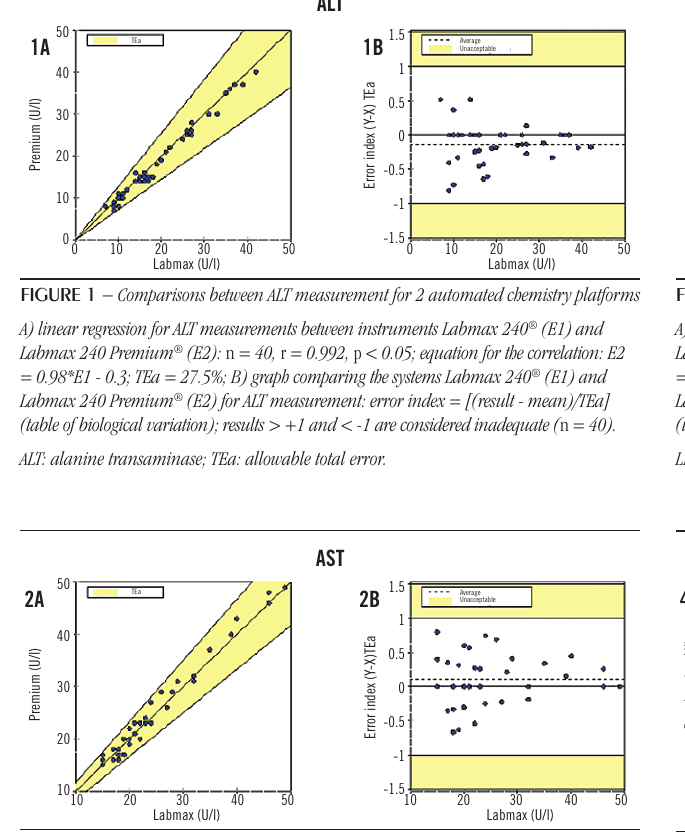
figurE 4 − Comparisons between UA measurement for 2 automated chemistry platforms A) linear regression for UA measurements between instruments Labmax 240 ® (E1) and Labmax 240 Premium ® (E2): n = 40, r = 0.998, p < 0.05; equation for the correlation: E2 = 0.979*E1 + 0.03; TEa = 12%; B) graph comparing the systems Labmax 240 ® (E1) and Labmax 240 Premium ® (E2) for UA measurement: error index = [(result - mean)/TEa] (table of biological variation); results > +1 and < -1 are considered inadequate ( n =